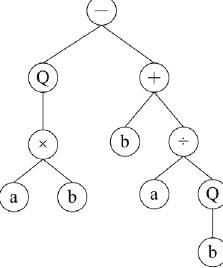
Fig. 2. Example expression tree in GEP. (Q represents the square root